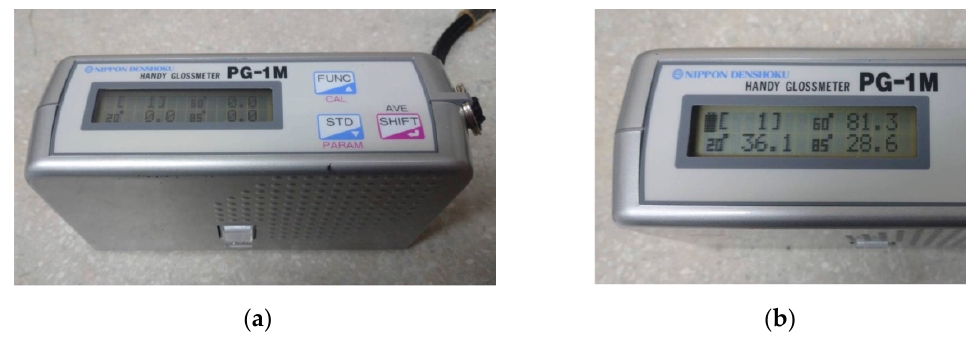
Figure 5. ( a ) Surface roughness meter and ( b ) its measurement screen.